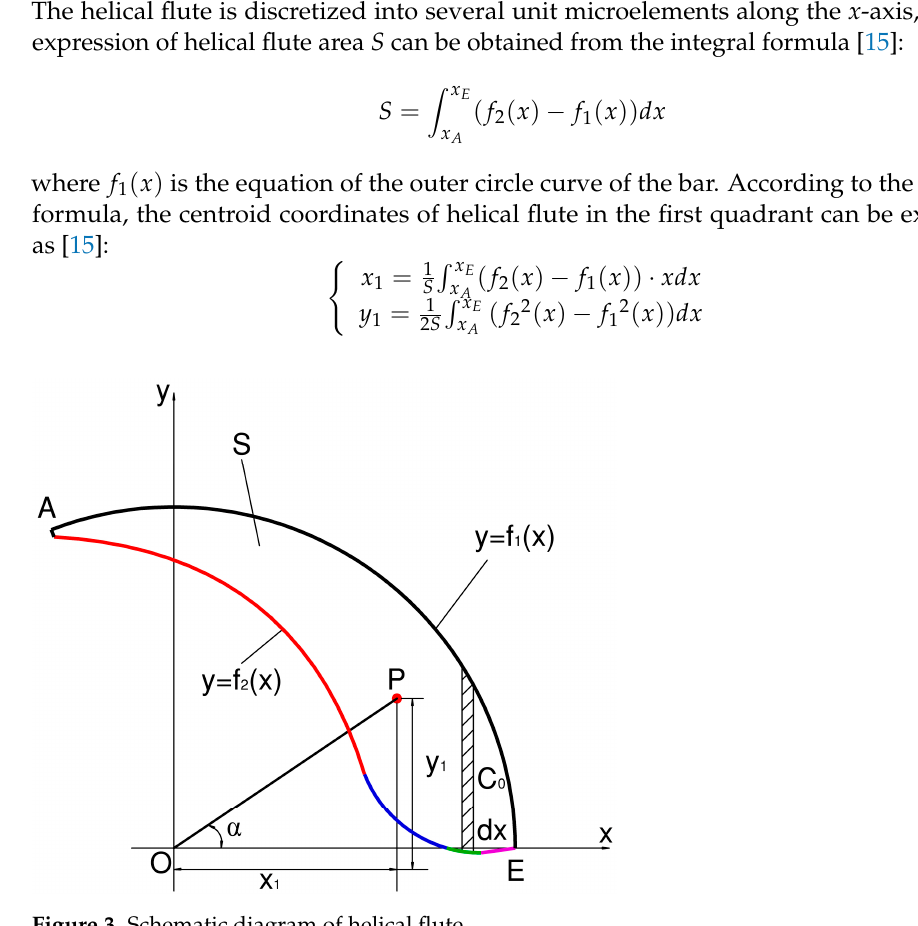
Figure 3. Schematic diagram of helical flute.